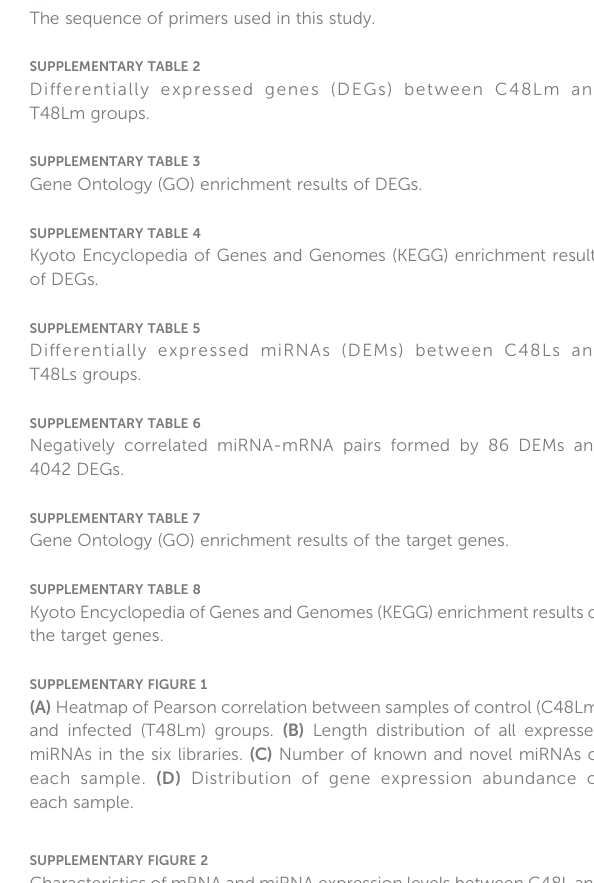
SUPPLEMENTARY FIGURE 2 Characteristics of mRNA and miRNA expression levels between C48L and T48L groups. (A) Volcano plot of distribution trends for differentially expressed genes (DEGs). (B, C) Heatmaps of expression levels for all DEGs and immune-related genes. (D) Scatter map of differentially expressed miRNAs